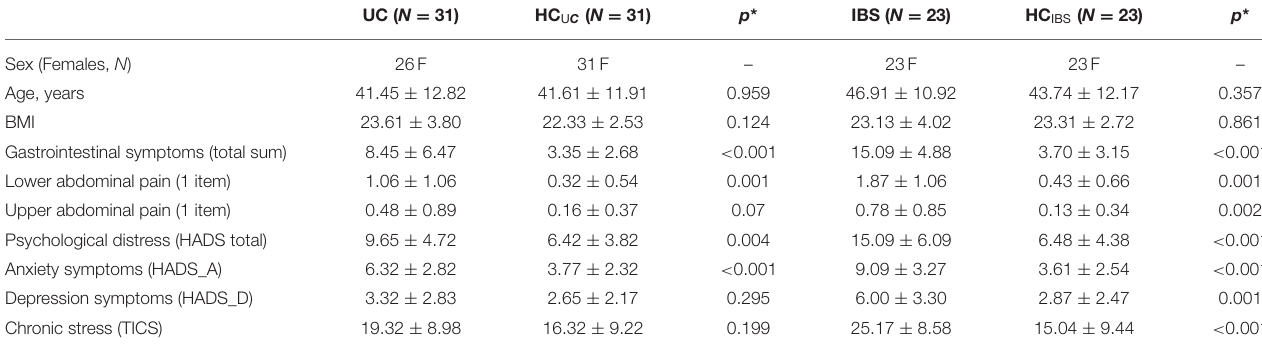
TABLE 1 | Sociodemographic, clinical, and psychological self-report